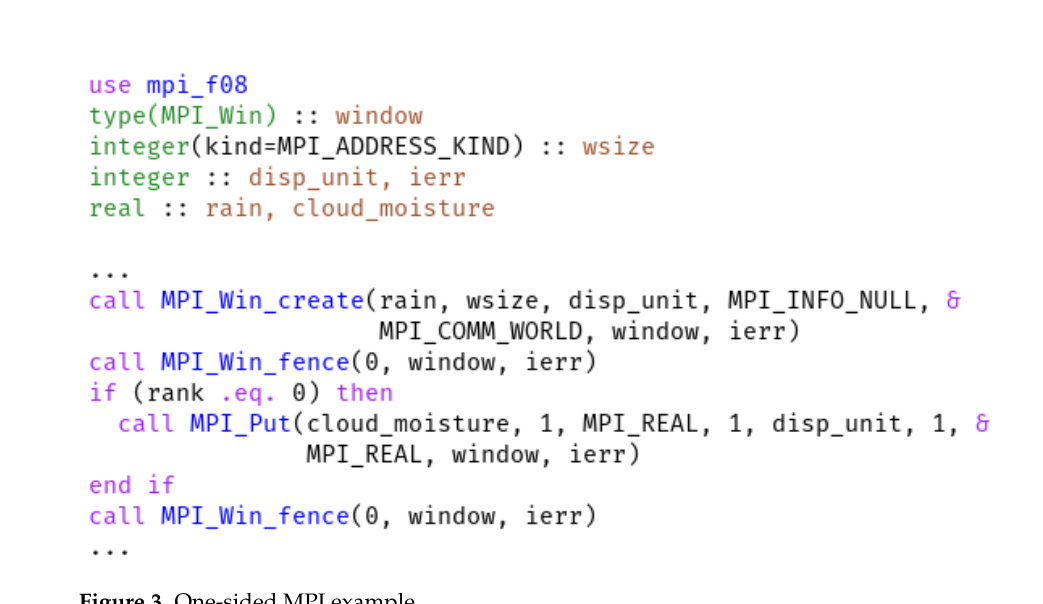
Figure 3. One-sided MPI example.